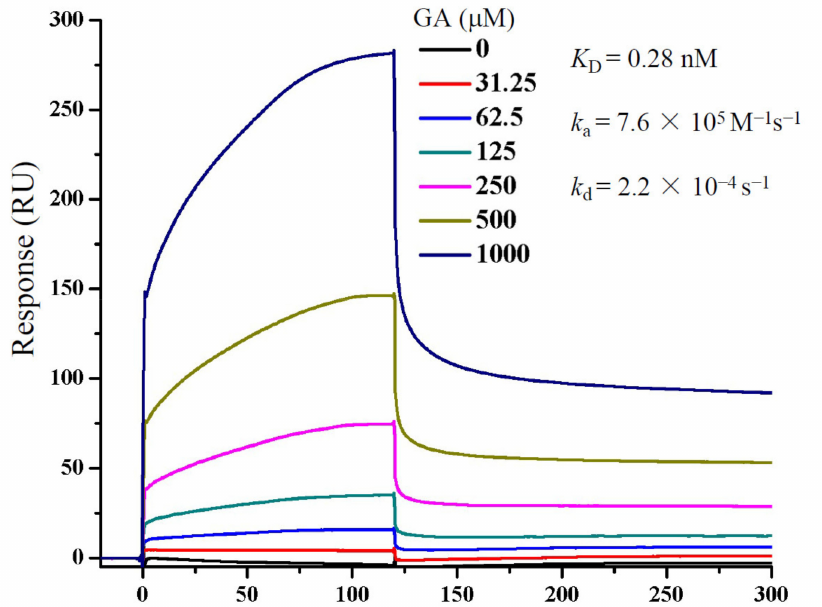
Figure 4. Determination of GA binding to S protein by SPR. S protein was immobilized on to a CM5 sensor chip. GA at concentrations as indicated was passed over the chip, and SPR angle changes were recorded using the Biacore T200 system and reported as response units (RUs). Data fitting was performed using the 1:1 Langmuir model in the BIAevaluation software package (GE